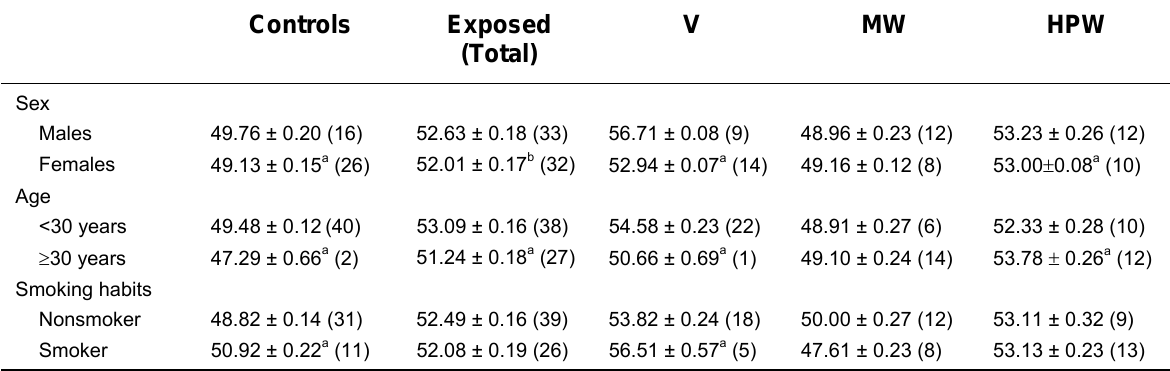
Influence of Sex, Age, and Smoking Habits on DNA Damage (TL [µm], mean ±